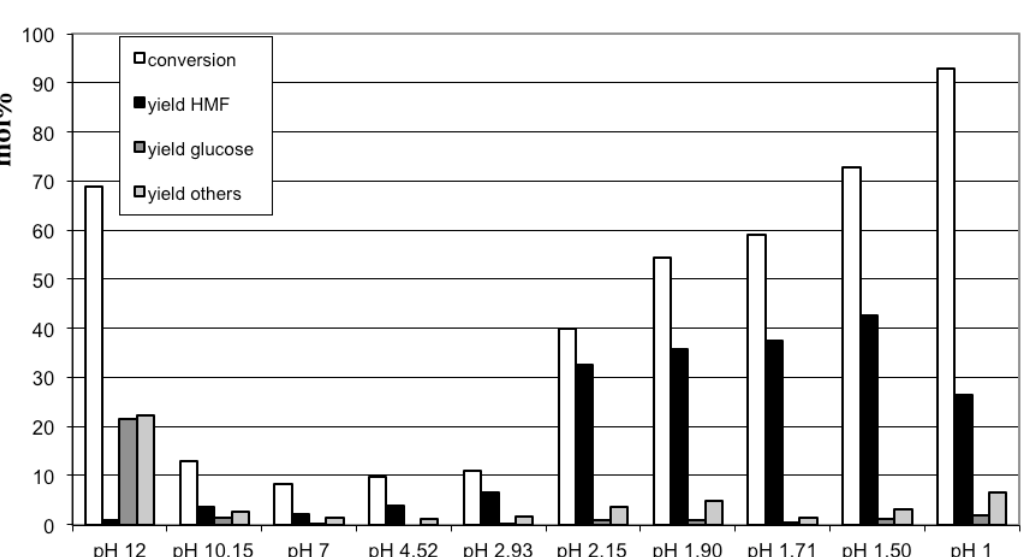
Figure 3. Fructose conversion at 150 °C in aqueous solutions of various